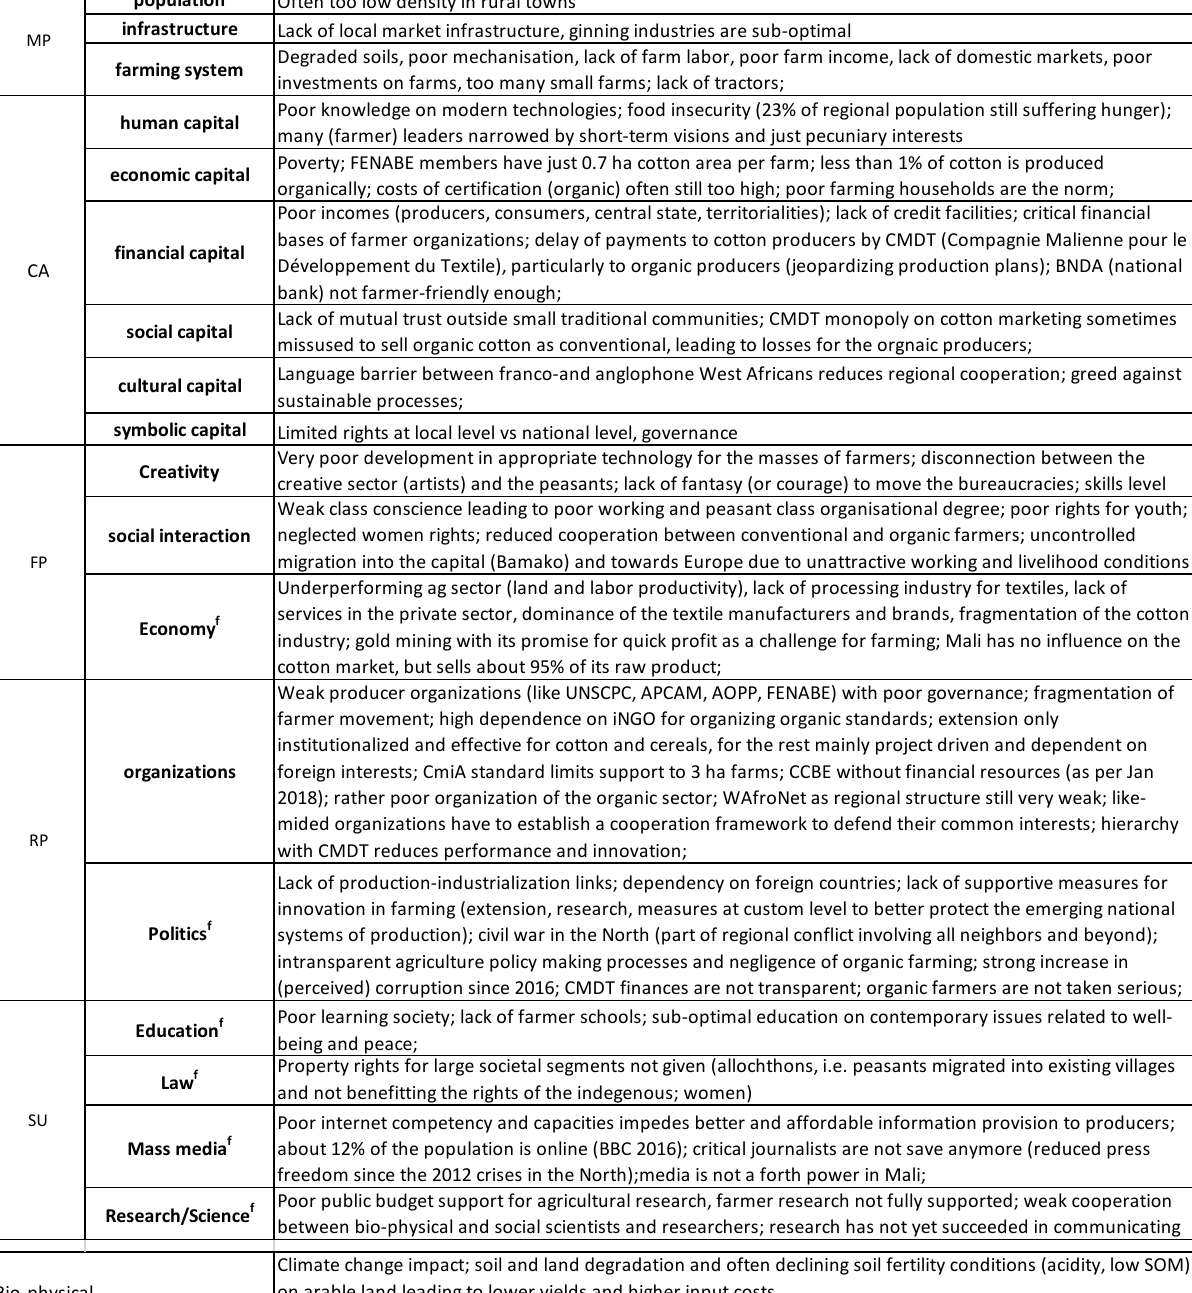
Table 2: Hypothesized problematic variables and facts based on a first